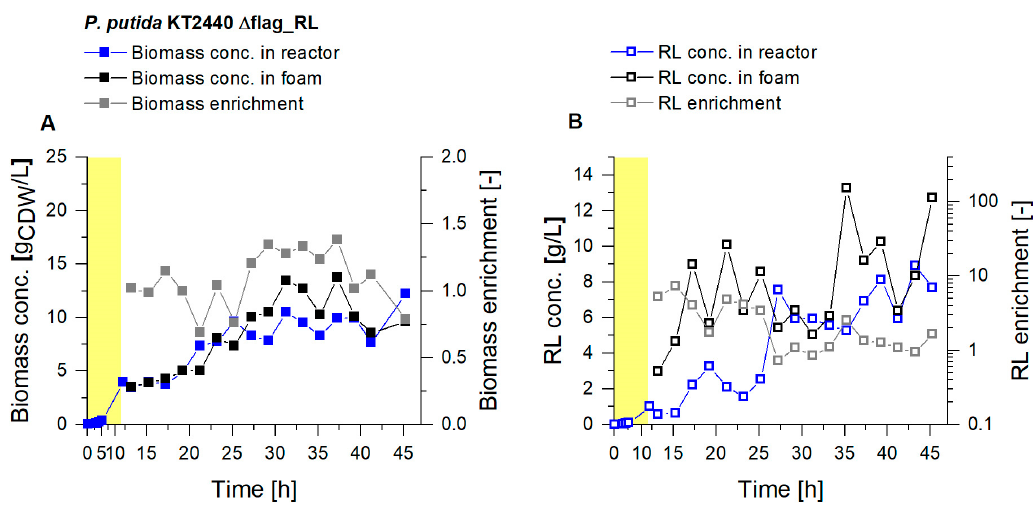
Figure 7. Cultivation of P. putida KT2440 Δ flag_RL in a bioreactor with 9 L working volume. Growth phase (yellow background) and a subsequent continuous product separation during the harvest phase (t = 12 h to t = 46 h). ( A ) Biomass concentration in the reactor (blue) and in the fractionated foam (black) and the biomass enrichment ( E X , gray). ( B ) Surfactant concentrations were measured in the fermentation broth of the reactor (blue) and in the fractionated foam (black), depicted together with the RL enrichment ( E P , gray).